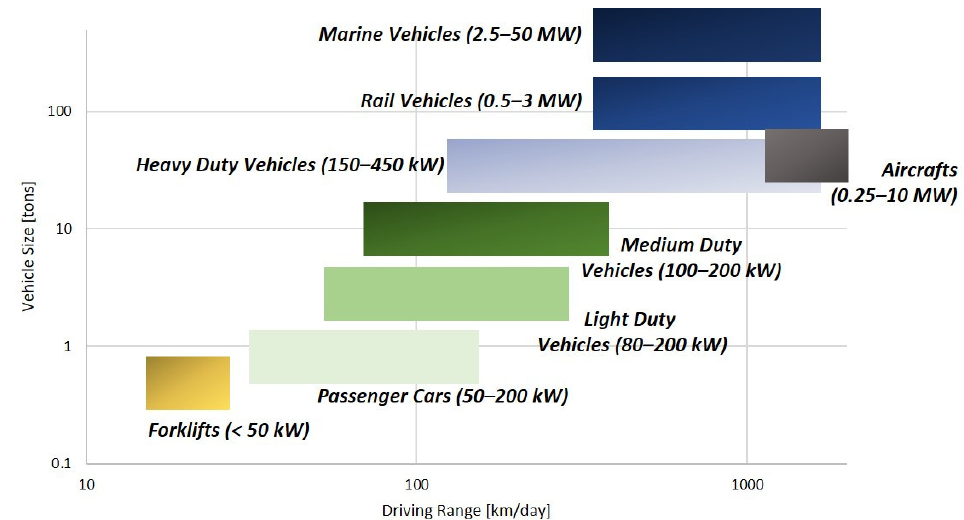
Figure 2. Size powers of the FCEVs in different transportation systems over the traveled distance.